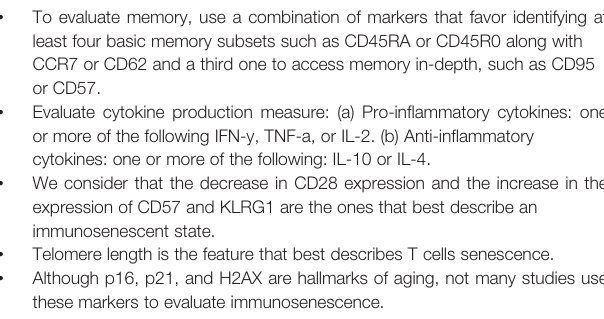
TABLE 6 | Recommendations for the study of immunosenescence in T cells by fl ow